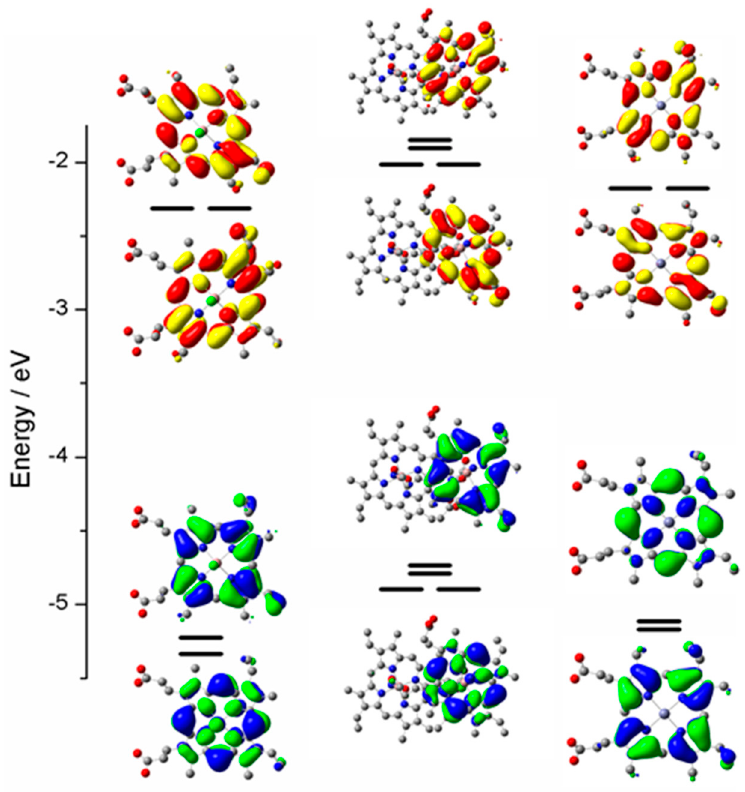
Figure 10. Relative energies of the four Gouterman orbitals of Ga(III)-PPIX, (Ga(III)-PPIX) 2 and Zn(II)-PPIX. Only the electron density distribution of top ring of the dimer is shown for the (Ga(III)-PPIX) 2 . Colored lobes represent positive and negative phases of the orbitals. For the occupied molecular orbitals the two phases are indicated by green and blue isosurfaces; for the unoccupied molecular orbitals the two phases are indicated by red and yellow isosurfaces. Reproduced with permission of American Chemical Society [98].